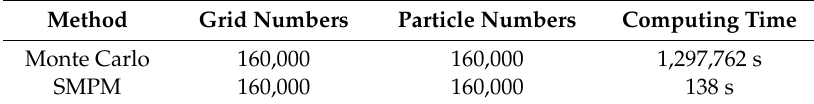
Figure 6. Pressure p ∗ response of location F by various methods with C.V = 0.01 and C.V = 0.05: Figure 6. Pressure * p response of location F by various methods with C.V = 0.01 and C.V = 0.05: ( a ) ( a ) Mean of pressure p ∗ with C.V = 0.01; ( b ) Variance of pressure p ∗ with C.V = 0.01; ( c ) Mean of Mean of pressure * p with C.V = 0.01; ( b ) Variance of pressure * p with C.V = 0.01; ( c ) Mean of pressure p ∗ with C.V = 0.05; ( d ) Variance of pressure p ∗ with C.V = 0.05. pressure * p with C.V = 0.05; ( d ) Variance of pressure * p with C.V = 0.05 . Table 3. Computing time of the methods (example 1, C.V =